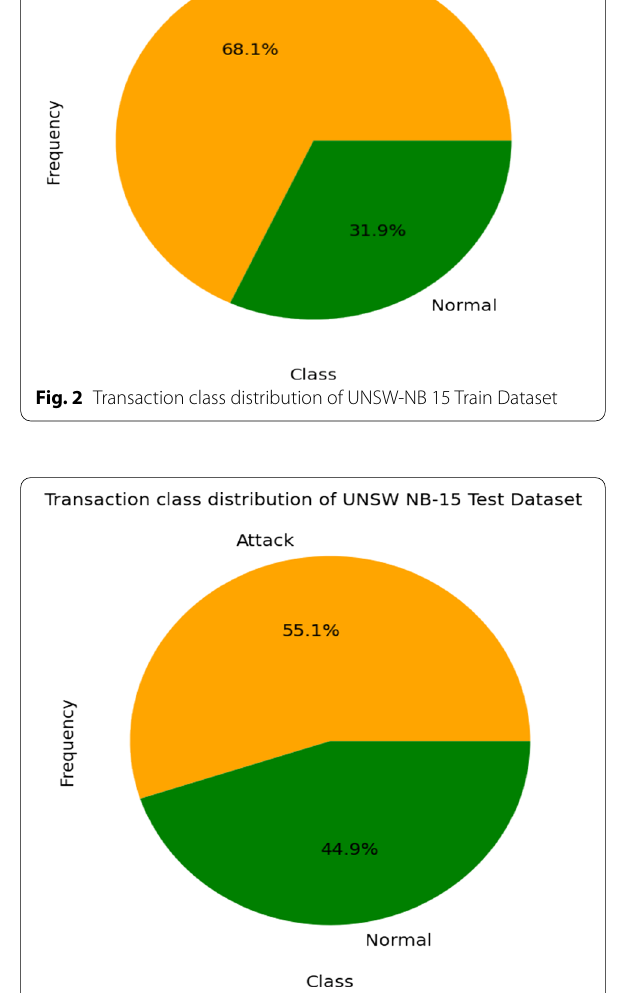
Fig. 3 Transaction class distribution of UNSW-NB 15 Test